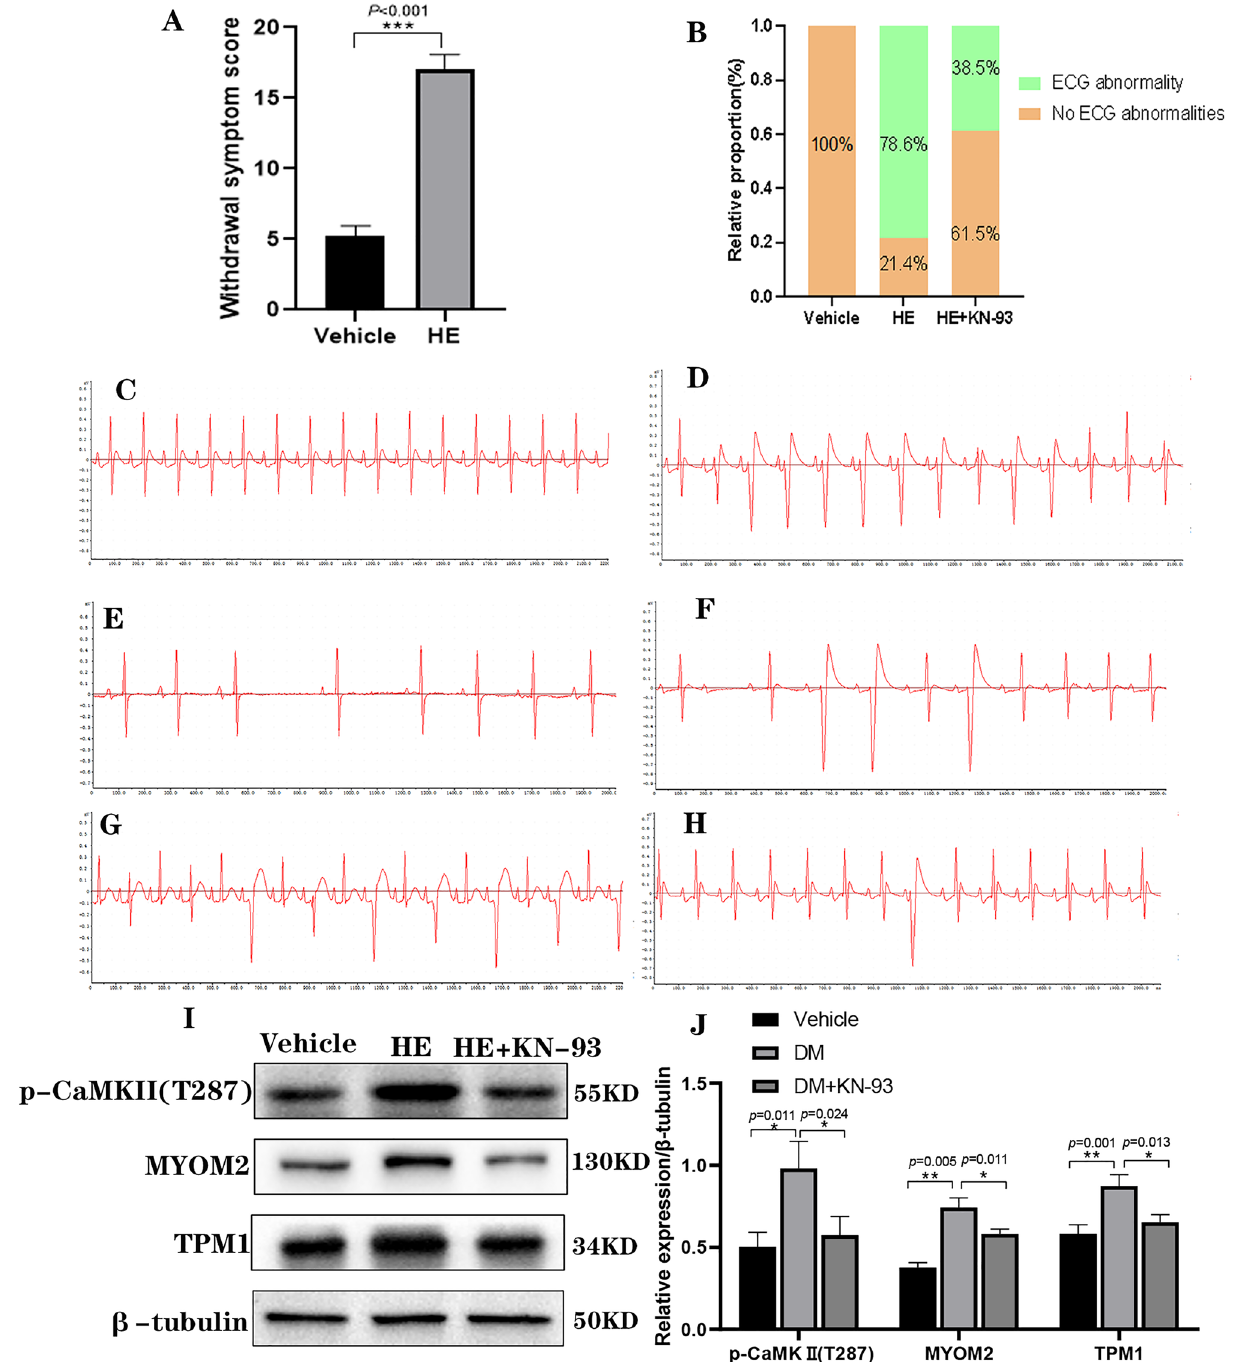
Figure 5. Effect of KN-93 on electrocardiogram and myocardial tissue p-CaMKII (T287), TPM1 and MYOM2 proteins in diacetylmorphine addicted rats. ( A ) Withdrawal symptom score. ( B ) Incidence of ECG abnormalities in each group of rats. ( C ) ECG of Vehicle group rats (50 ms/div). ( D – G ) Representative electrocardiogram of HE group rats (50 ms/div). ( H ) Representative ECG of rats in HE + KN-93 group (50 ms/ div). ( I ) Western blotting of p-CaMKII(T287), TPM1, and MYOM2 in myocardial tissue of Vehicle group, HE group, and HE + KN-93 group, original blots are presented in Supplementary Information Fig. 5, samples derive from the same experiment and that blots were processed in parallel. Quantification is in ( J